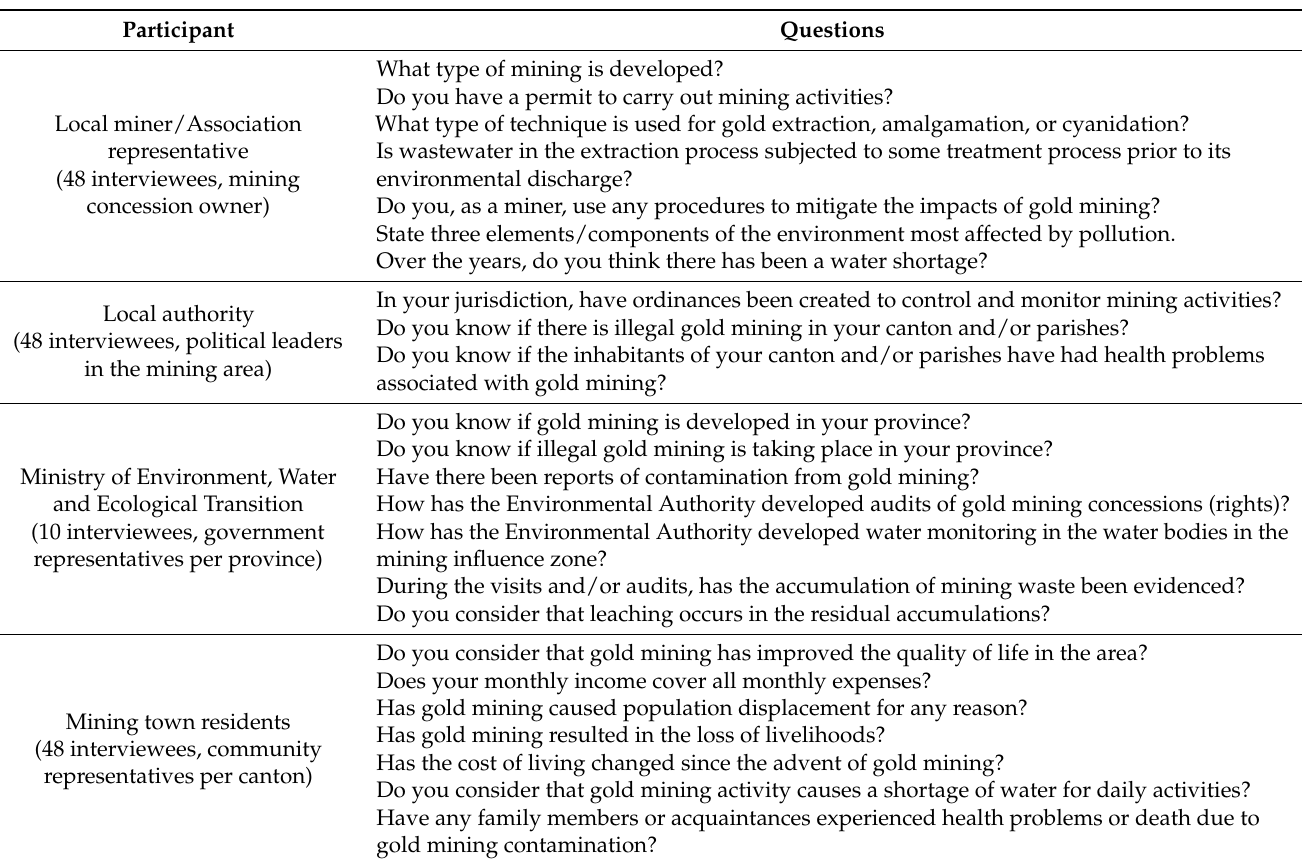
Table 4. Questions set to analyze the current situation of Au